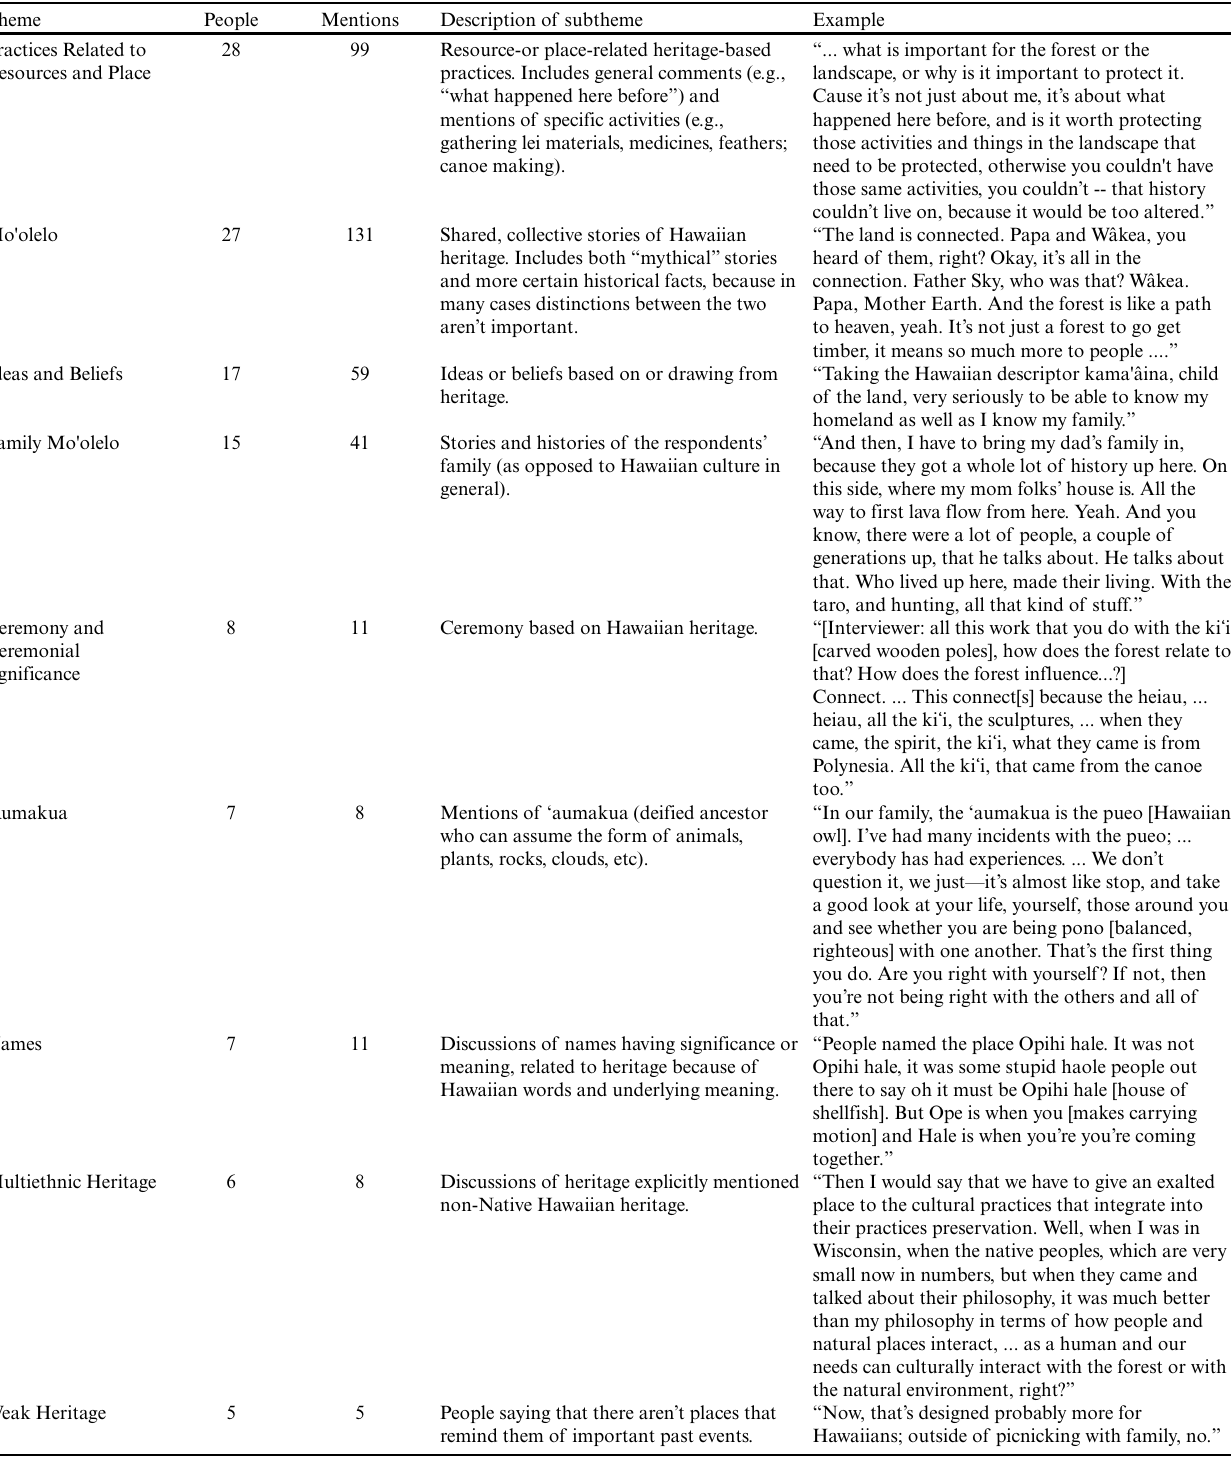
Table 4 . Heritage subcodes. A division of the 385 references to heritage into subthemes, with an example provided for each subtheme. Theme People Practices Related to Resources and